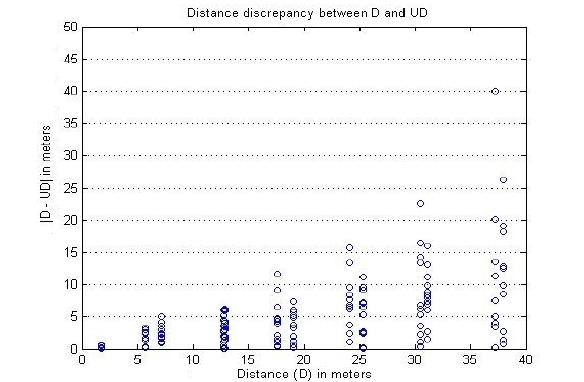
Figure 6. Distance discrepancy measured between the physical distance ( D ) and the user measured signal distance ( UD ).